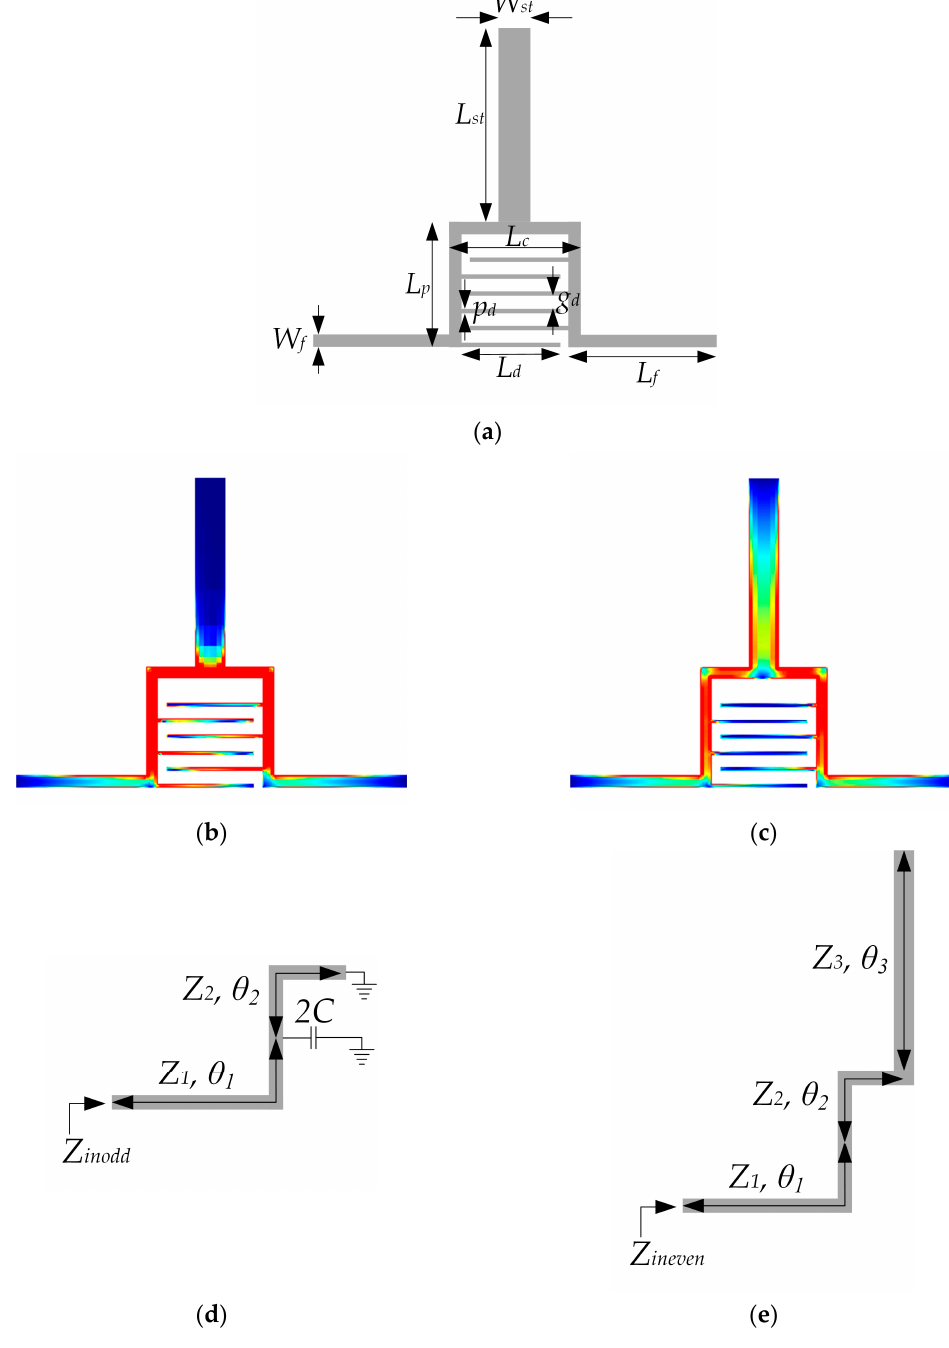
Figure 1. ( a ) Configuration of the proposed dual-mode resonator; ( b ) Current distribution for the odd mode; ( c ) Current distribution for the even mode; ( d ) Odd-mode equivalent circuit; ( e ) Even-mode equivalent circuit.